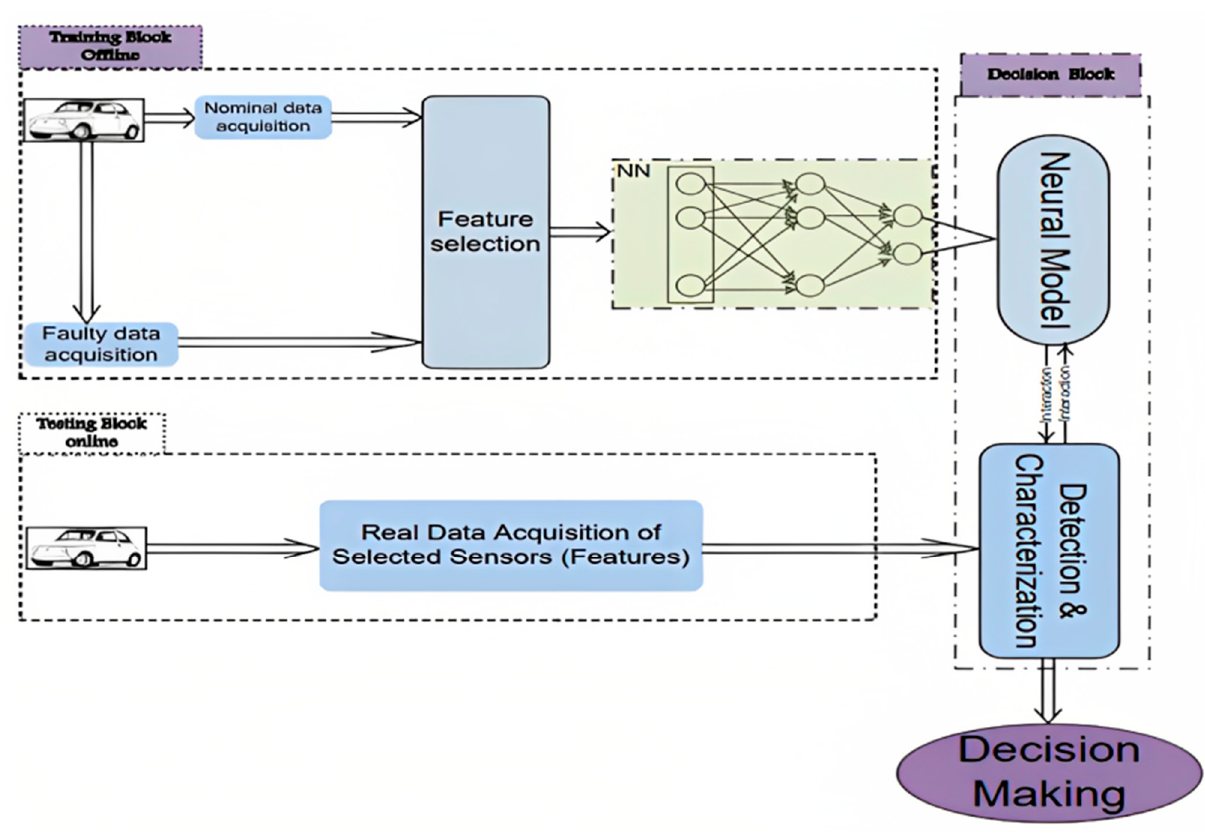
Figure 23. Detection and characterization